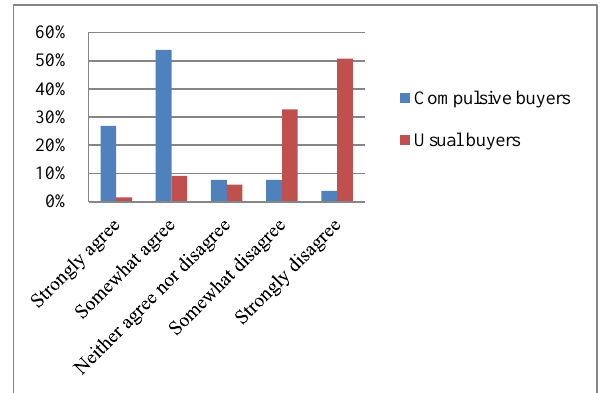
Fig. 1 . “If I have any money left at the end of the pay period, I just have to spend it.”